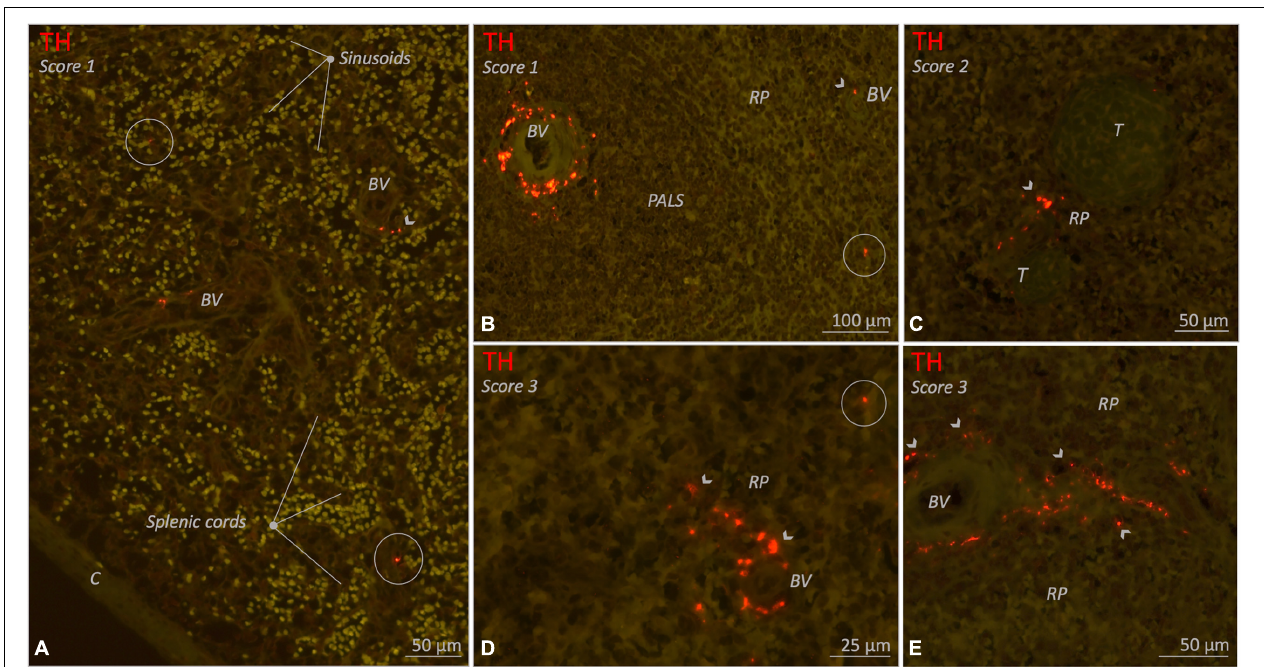
FIGURE 7 | Fluorescence microscopic images of various red pulp related sympathetic nerve densities (TH staining) in different 10–25 year age group individuals. Sympathetic nerves are present as discrete structures running in the splenic cords (encircled structures) or as nerves that originate from a perivascular or trabecular plexus and from there diverge further into the red pulp (RP) (arrow heads). (A) Splenic sample with clear splenic cords and sinusoids and a low density (score 1) of sympathetic nerves. (B–E) Various examples of spleens with RP related nerves either as a low density (score 1), a moderate density (score 2) or a high (score 3) RP related sympathetic nerve density. C, capsule; BV, blood vessel; PALS, periarteriolar lymphatic sheath; RP, red pulp; T,